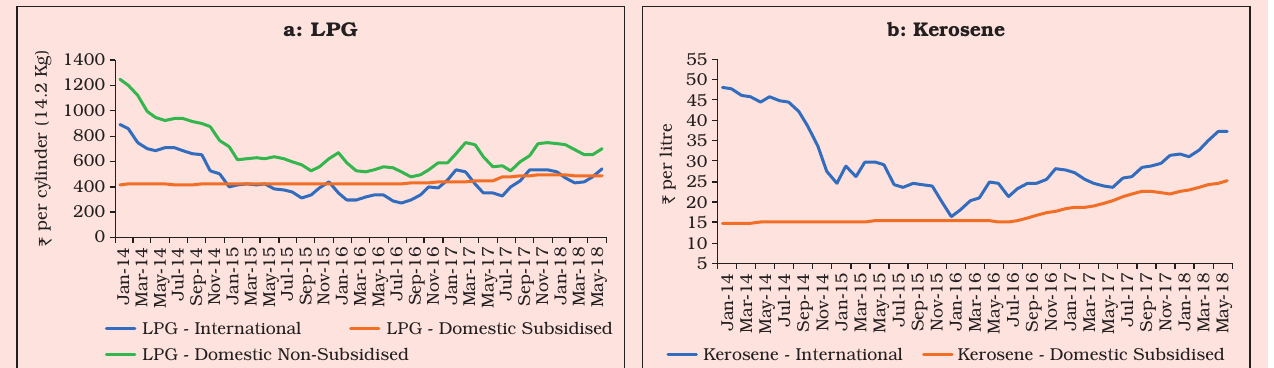
Chart II.2.5: Movements in Domestic and International Prices of LPG and